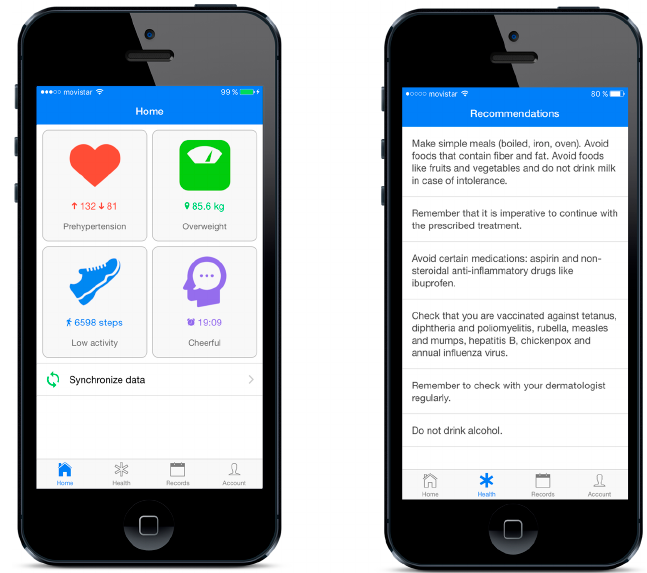
Figure 9. Mobile application views: main view ( Left ) and recommendations view ( Right ).